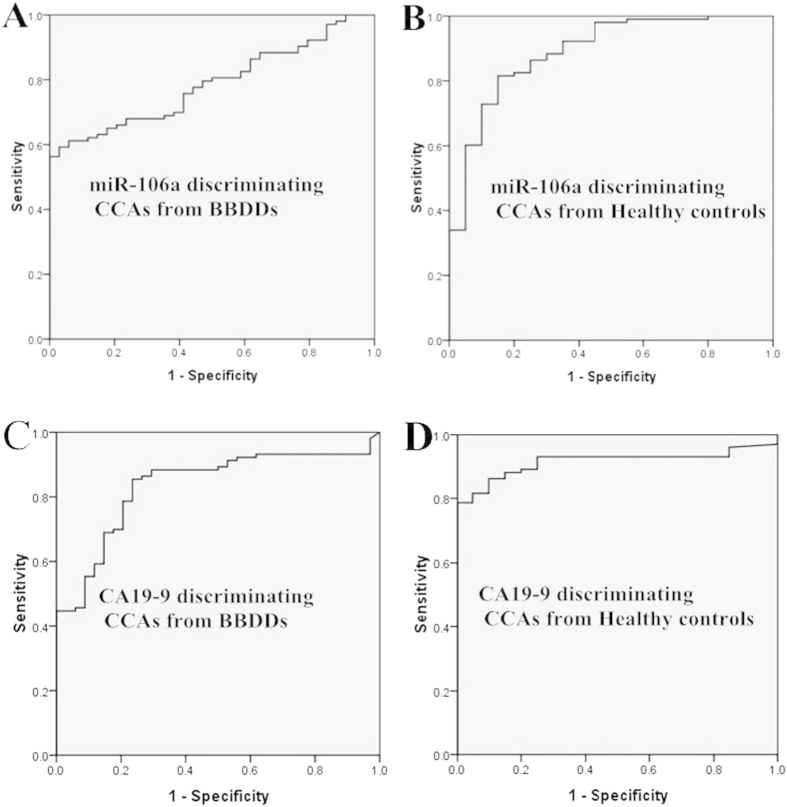
ROC curve analysis of serum miR-106a and CA19-9 for the diagnosis of CCA form BBDD or healthy controls.(A) AUC of serum miR-106a for discriminating CCA patients from BBDD patients; (B) AUC of serum miR-106a for discriminating CCA patients from healthy controls; (C) AUC of serum CA19-9 for discriminating CCA patients from BBDD patients; (D) AUC of serum CA19-9 for discriminating CCA patients from healthy controls.